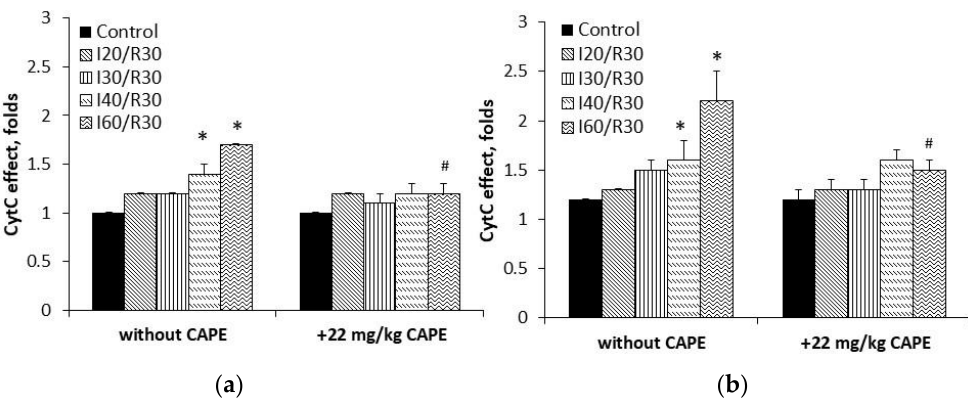
Figure 6. Effect of ischemia/reperfusion and CAPE on cytochrome c effect. Measurements were performed in the presence of 5 mM glutamate + 5 mM malate ( a ) or 15 mM succinate (+ 50 nM rotenone) as substrates ( b ). Cytochrome c effect (Cyt c effect) was calculated as the ratio between oxygen uptake rates in state 3 in the presence of cytochrome c and state 3 (CytC effect = V CytC /V ADP ). * p < 0.05 vs. the respective control; # p < 0.05 vs. ischemia/reperfusion without CAPE. One-way ANOVA followed by a Fisher’s LSD post hoc test were used to compare the